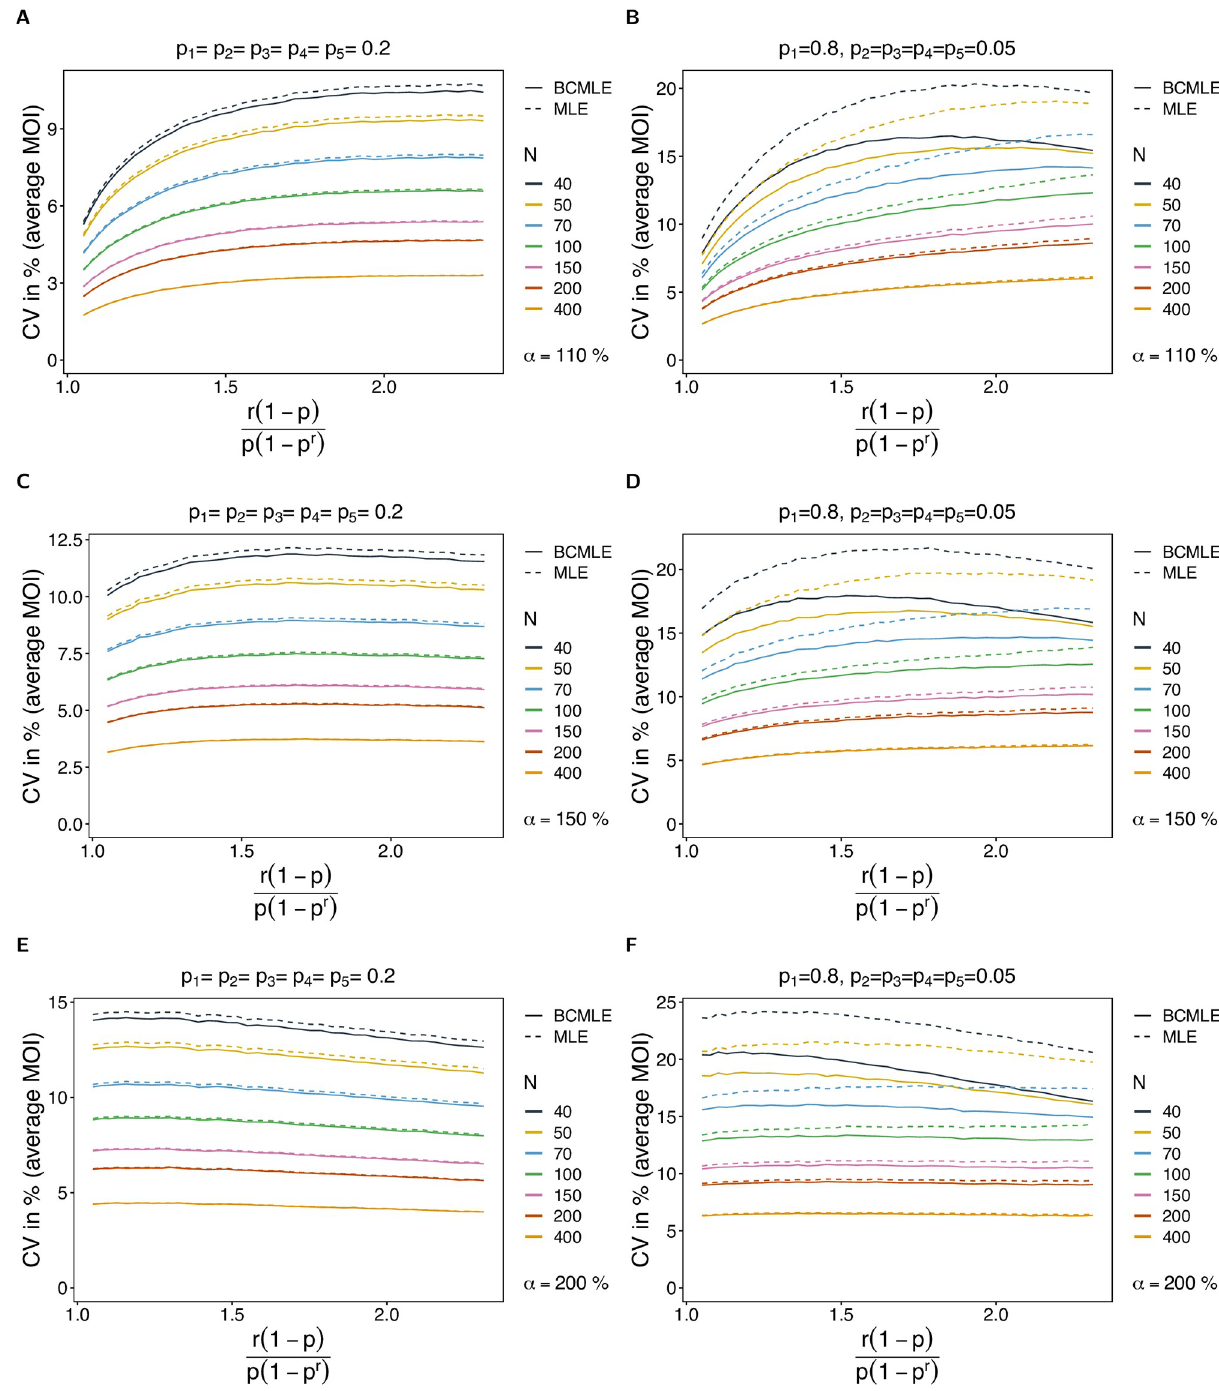
Fig 5. Variance if MOI estimates under model violations. Similar to Fig 4 but for the coefficient of variation in %.